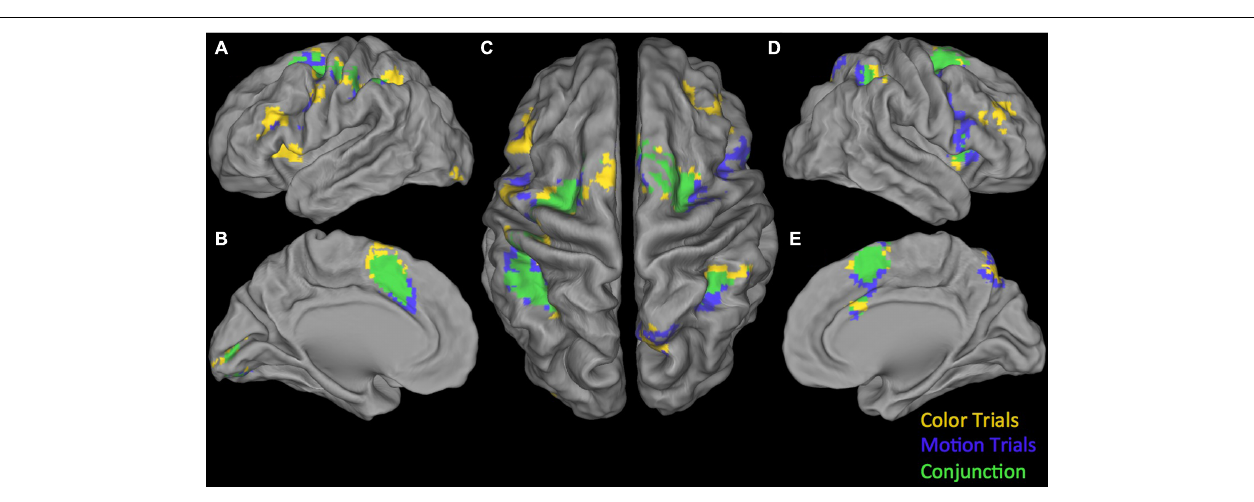
FIGURE 4 | Overview of negative parametric effects in color (yellow) and motion (blue) trials and their conjunction (green). (A) Lateral view of left Hemisphere, (B) Medial view of left Hemisphere, (C) Dorsal view, (D) Lateral view of right Hemisphere, and (E) Medial view of right Hemisphere. See Tables 2–4 for